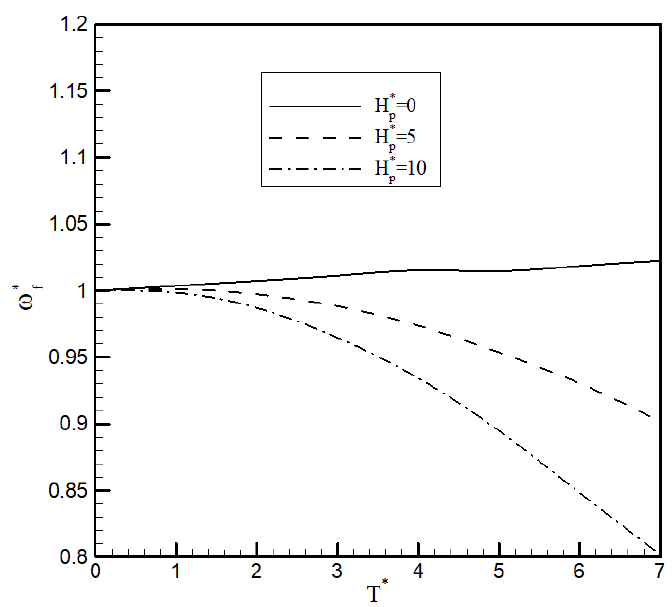
Figure 5. The effect of tip propulsor thrust and angular momentum on the flutter frequency of the wing (case